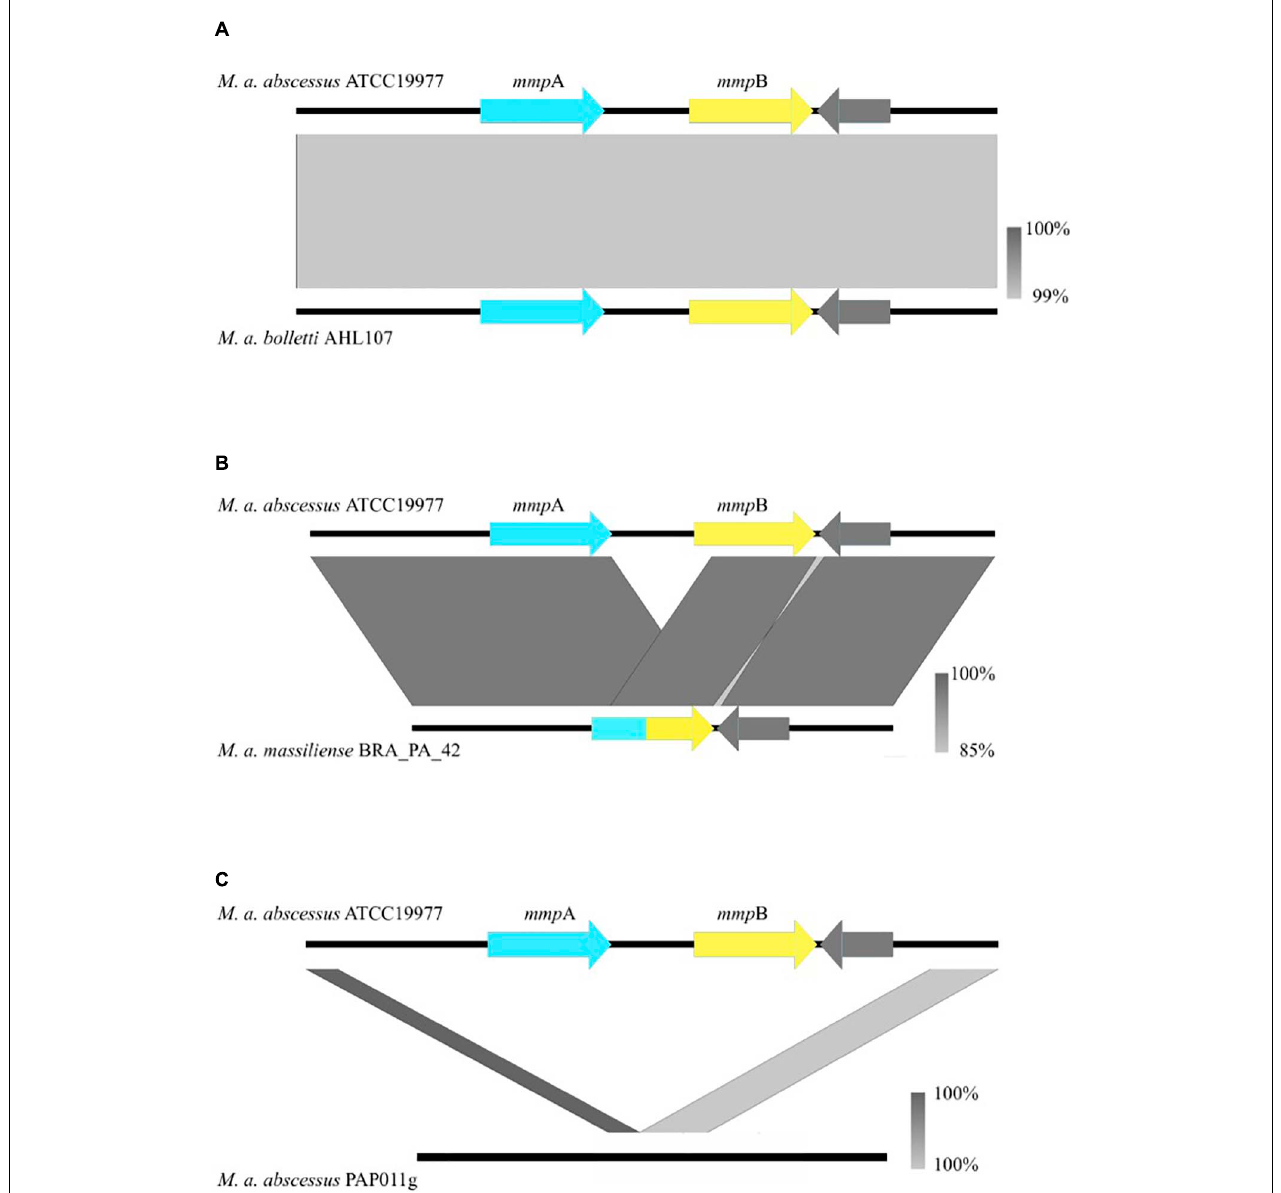
FIGURE 1 | Nucleotide BLAST comparisons between the mmpA/mmpB porin locus of Mabs ATCC 19977 and isolates that encode the variants observed in the porin locus both across the global population and longitudinally. The gray bars illustrate the various rearrangements [or no rearrangement in the case of (A)] observed in clinical isolates and are color-coded to indicate the percentage identity of the genomic sequences of the two isolates that are being compared. (A) Is an example of when mmpA and mmpB are both present. (B) Is an example of the fusion of mmpA and mmpB , resulting in a single mmp -like gene. (C) Is an example of the complete deletion of both mmp -like porin genes at the porin locus. Porin genes are colored in blue and